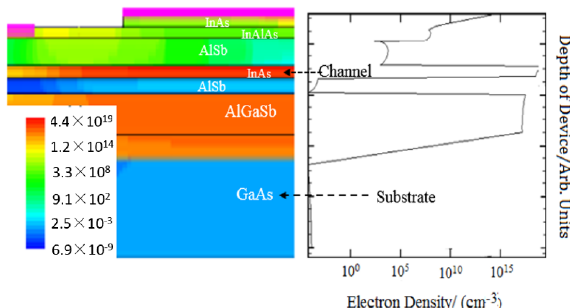
Figure 3. Distribution of electron concentration from simulation.